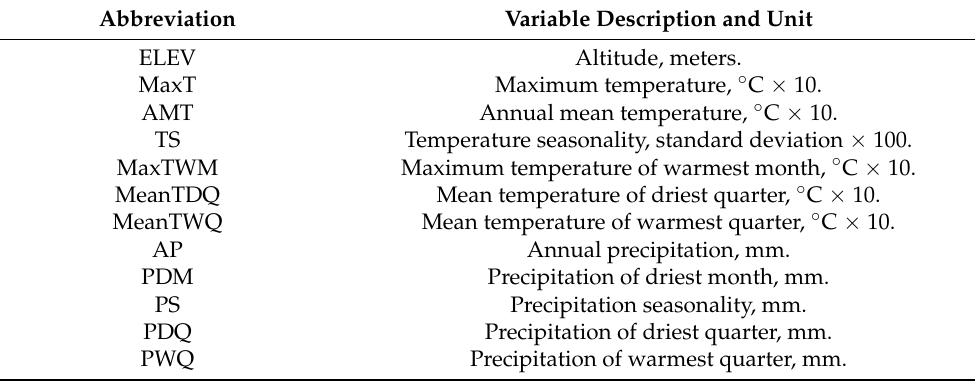
Table 7. List of geographic, climatic, and bioclimatic variables downloaded from the WorldClim